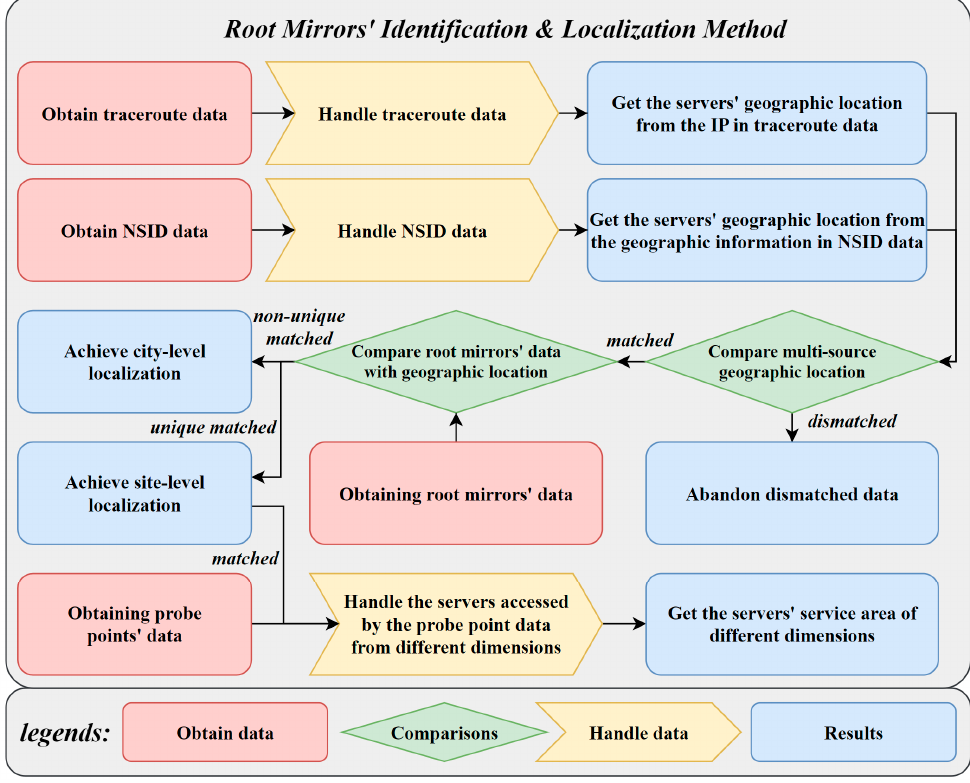
Figure 1. Root Mirrors’ Identi fi cation and Localization Method.